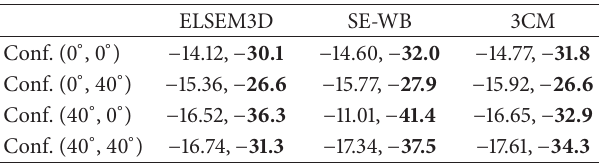
Table 2: Std. of power on the interval [0dB − 20 dB] (left) and on the interval [ − 20 dB − 40dB]